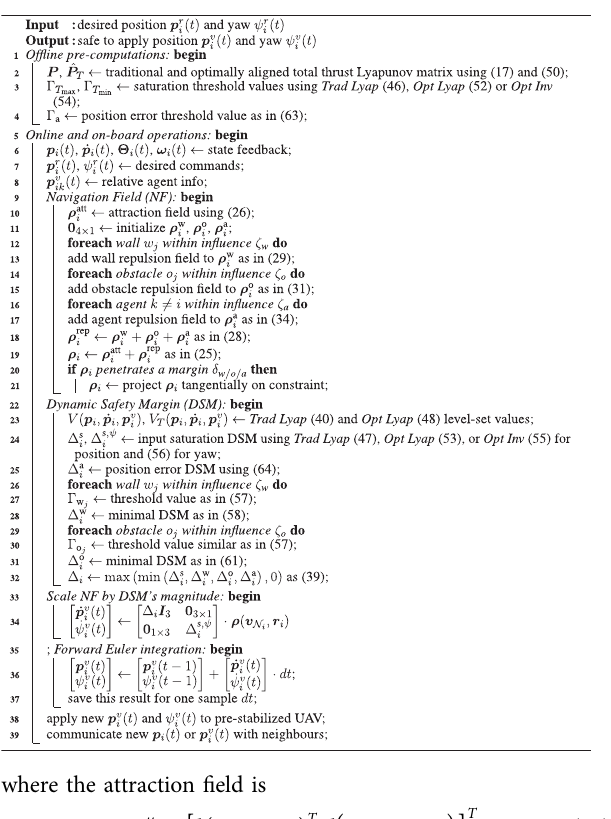
Algorithm 1 : Pseudocode of the Distributed Explicit Reference Governor (D-ERG) Algorithm for Agent i